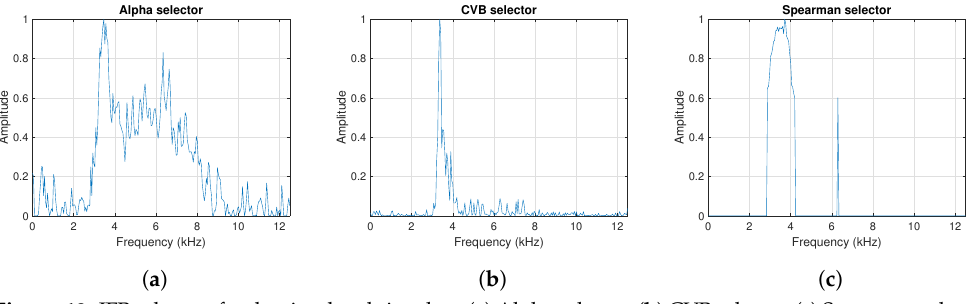
Figure 13. IFB selectors for the simulated signal s 2 . ( a ) Alpha selector. ( b ) CVB selector. ( c ) Spearman selector.